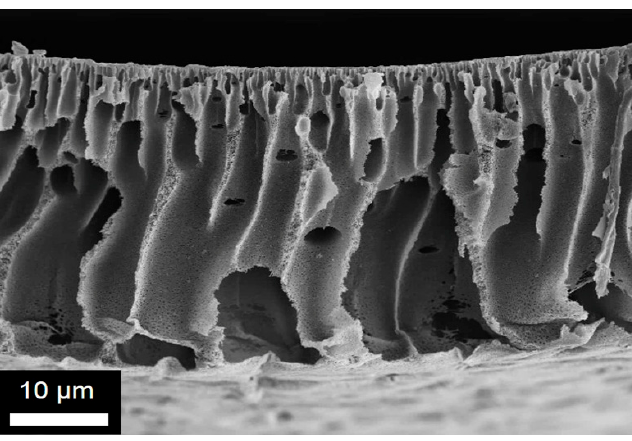
Table 7. Preparation of membranes with 80/20 w/w or 70/30 w/w PDSPP/SPDSPP in NMP at 10%,